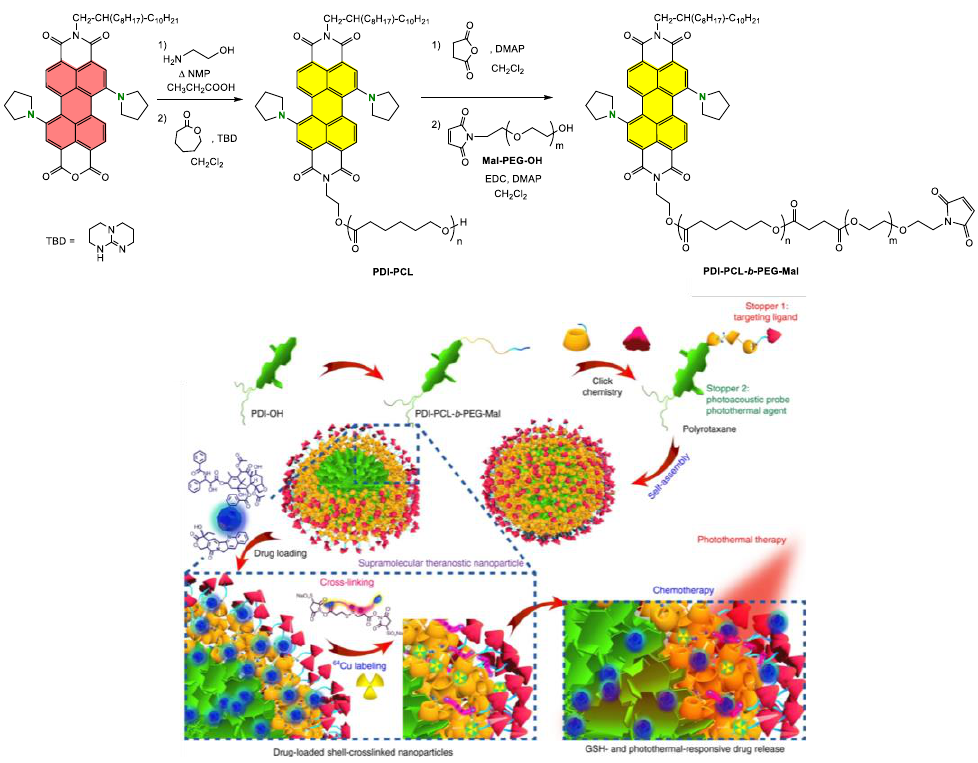
Figure 25. Synthesis of PDI-PCL-b-PEG-Mal; illustration of the preparation of drug-loaded SCNPs and dual-responsive drug release using polyrotaxane. Reprinted with permission from Ref. [136]. Copyright 2018 Nature Publishing Group.